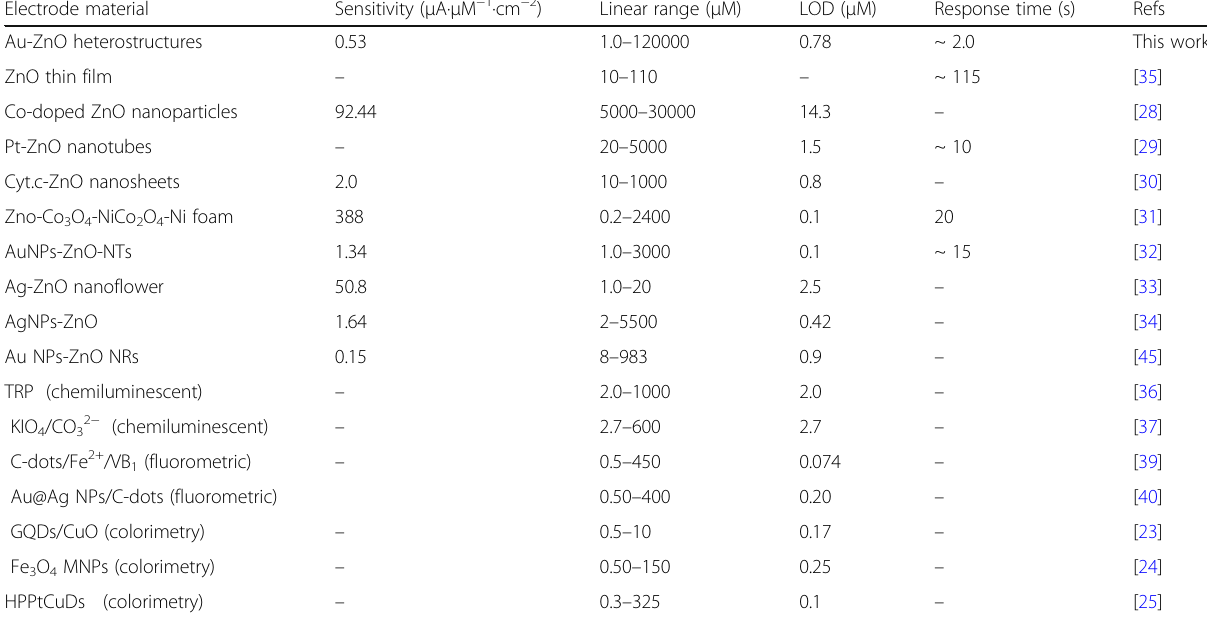
Table 2 Comparison of characteristics of the H 2 O 2 sensor based on ALD-developed Au-ZnO heterostructures with H 2 O 2 sensors based on other nanomaterials and detection modes reported to date Electrode